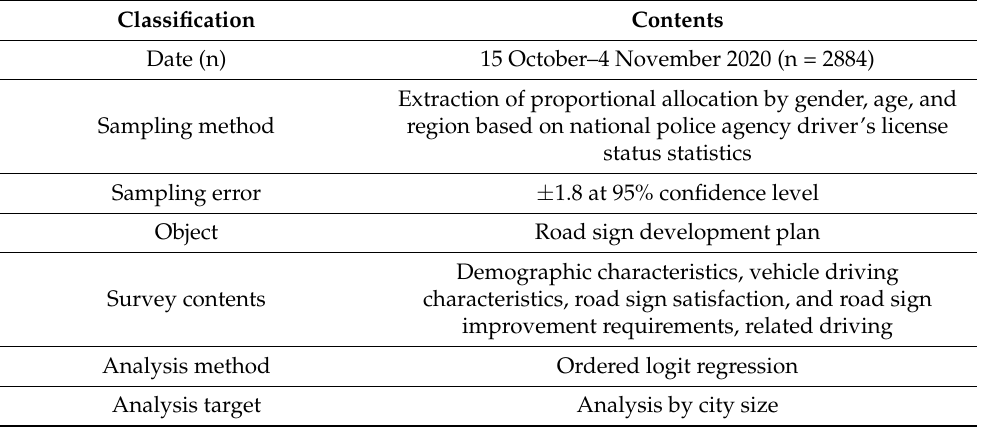
Table 1. Survey and analysis